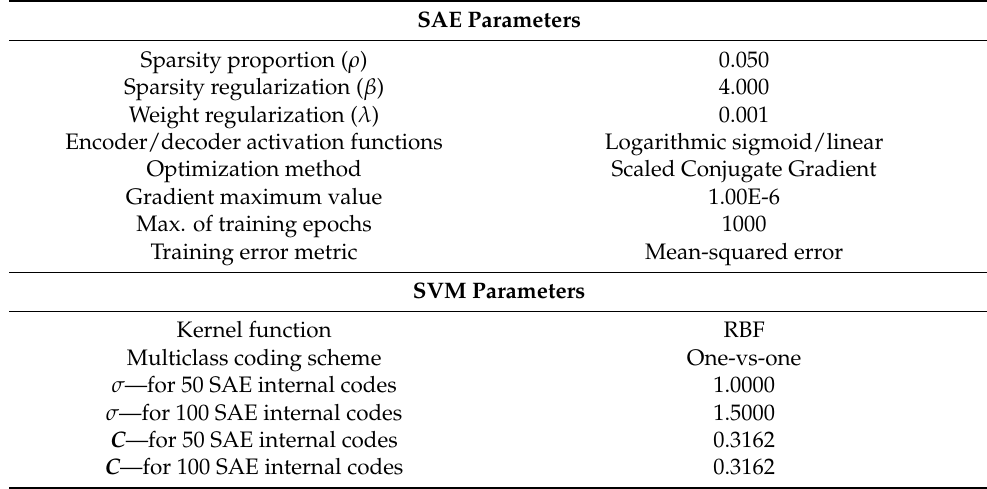
Table 2. SAE and SVM parameters of the proposed strategy for the numerical beam